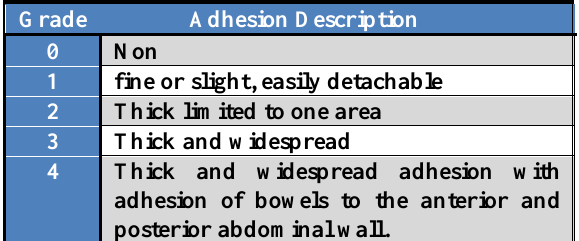
Table, 1: Blaur and Collins scale for the autopsy valuation of the P.O. intraperitoneal adhesions